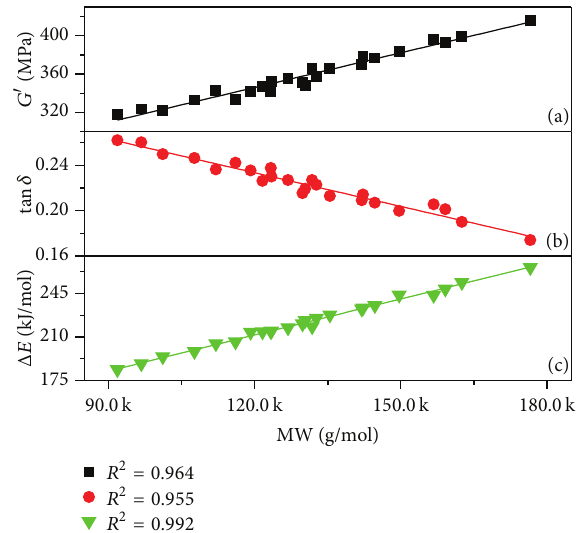
Figure 5: Correlation plots of MW with G 󸀠 (a), tan 𝛿 (b), and Δ E = 5 Figure 3: Storage modulus of copolymers synthesized at 𝑃 C 2 H 4 = 60 ∘ C, and 𝑡 = 30 min (samples 1, 2, and bar, 𝑇 polymerization polymerization 3).